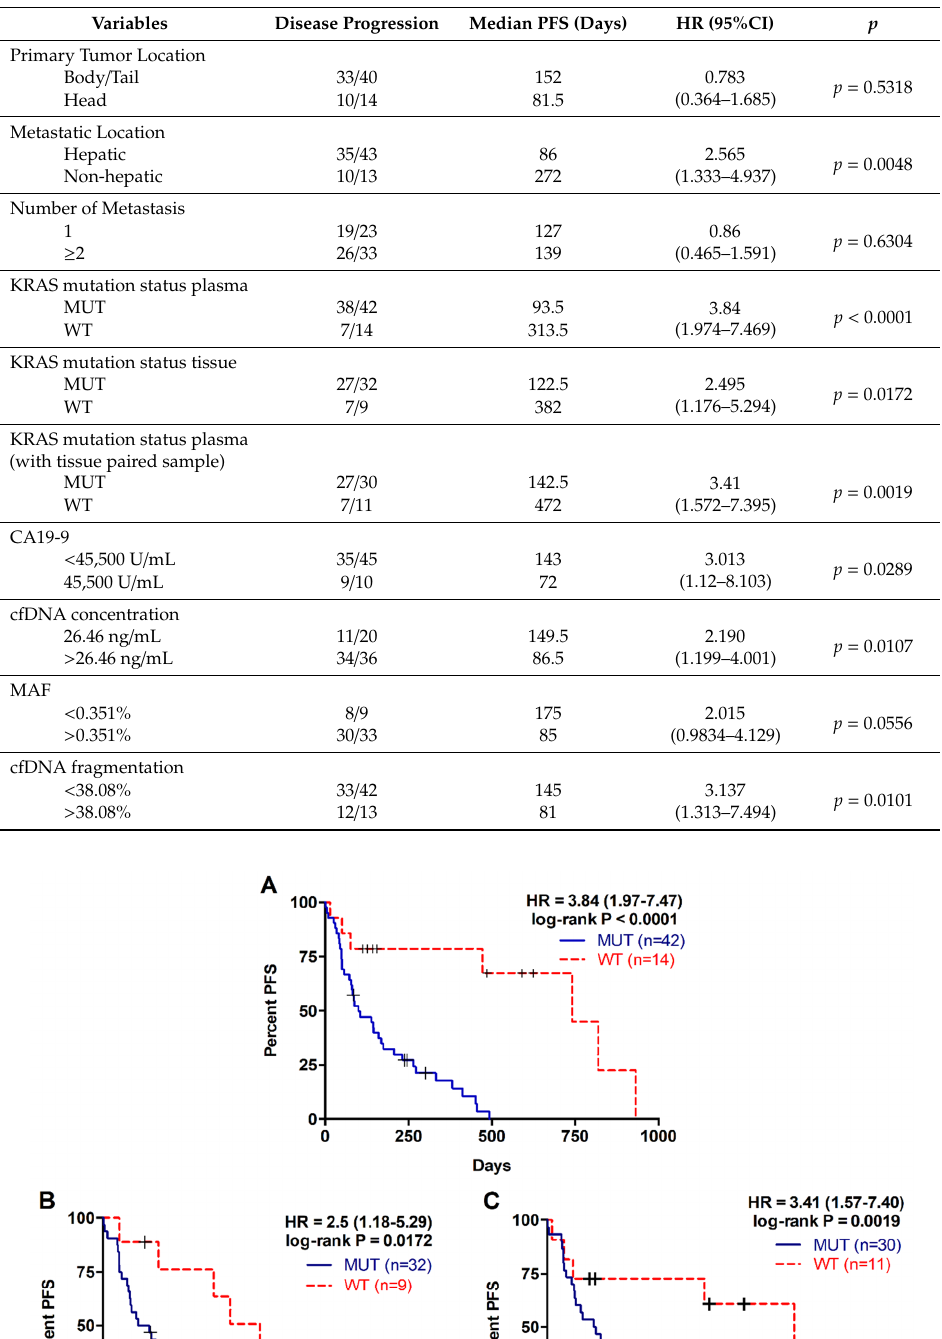
Table 3. Progression-free survival analysis.